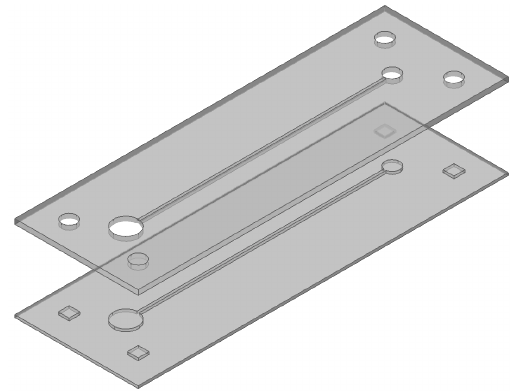
Figure 4. Schematics of the two substrates used in the bonding experiment. The upper substrate has two holes and a microchannel in the middle and four holes are located near the corner. The lower substrate has micro-rib and protrude structures which will result in interference fit with the upper